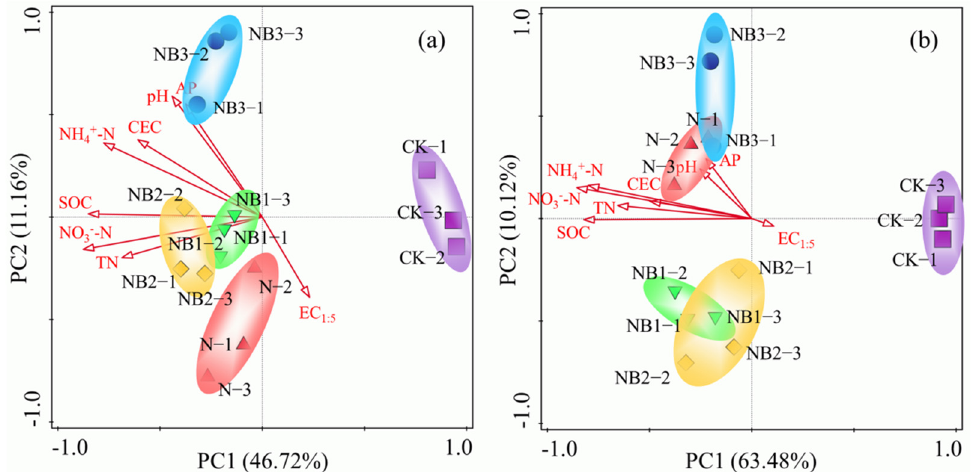
Figure 3. Principal coordinate analysis of AOA ( a ) and AOB ( b ) communities in soils with different salinities.